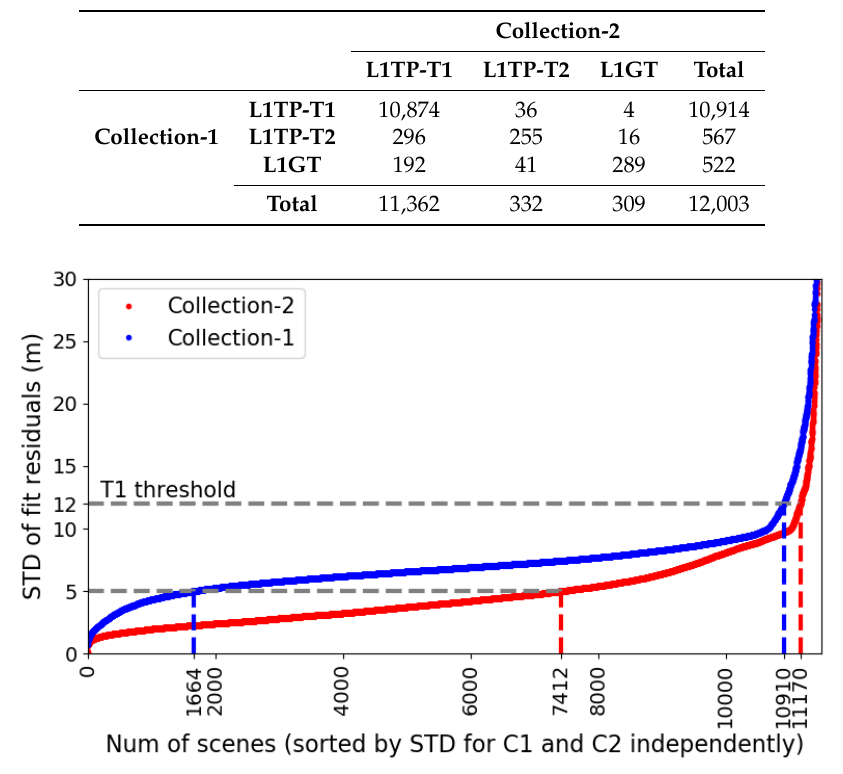
Table 15. Comparison of the product type expected in Collection-2 with the corresponding product types in Collection-1. One scene for each land path/row was processed using Collection-1 GCPs (Collection-1) and bundle-adjusted GCPs (Collection-2) using the same processing system. More L1TP (T1) products are expected to be generated in Collection-2 than in Collection-1.